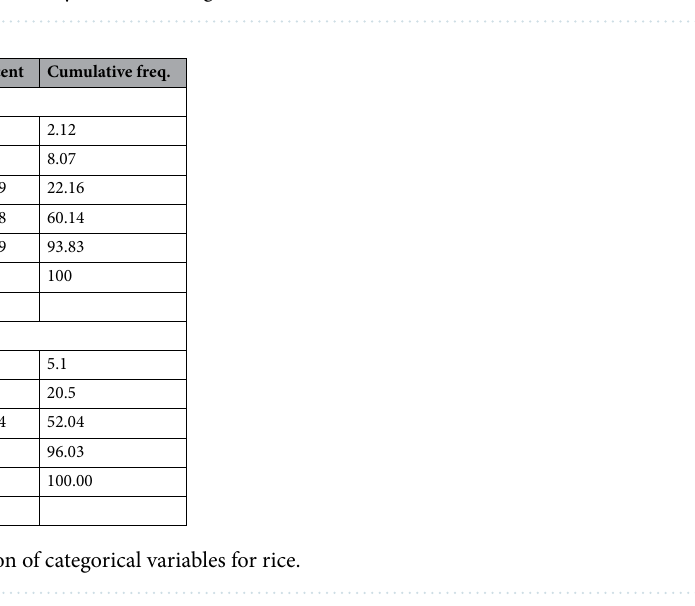
Figure 3. Rice varieties with mean of yield and sowing time.